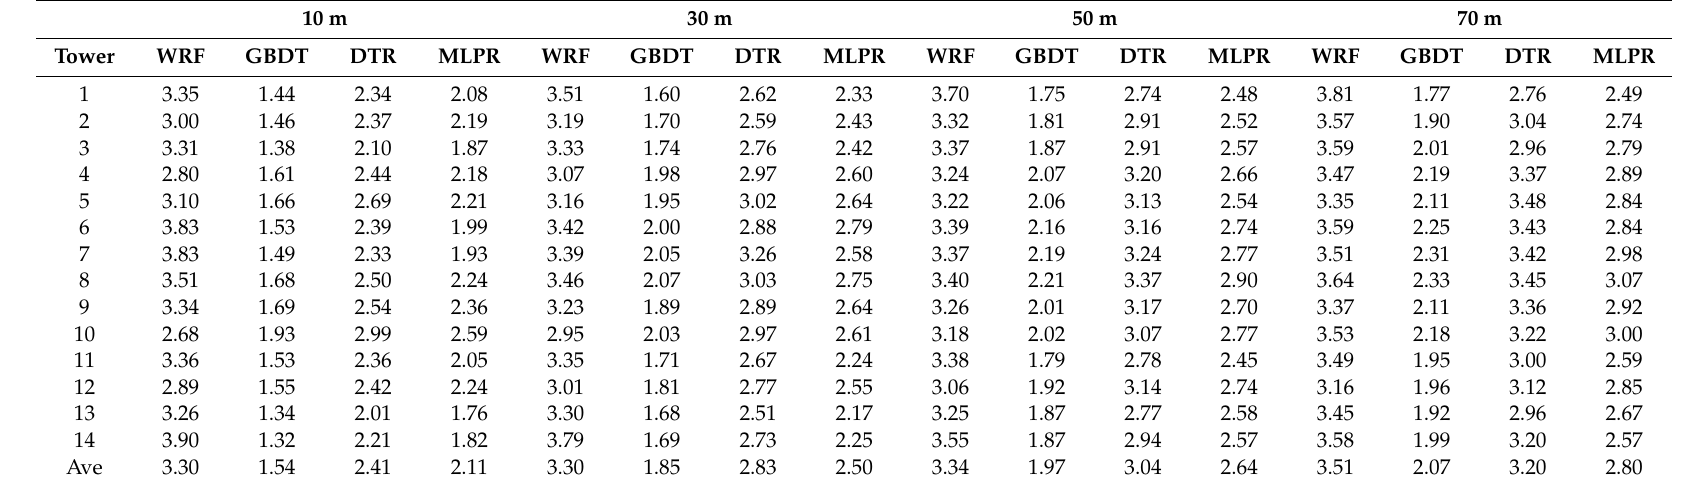
Table A3. The 48–72 h RMSE (m / s) of WRF model original output and post-processing model